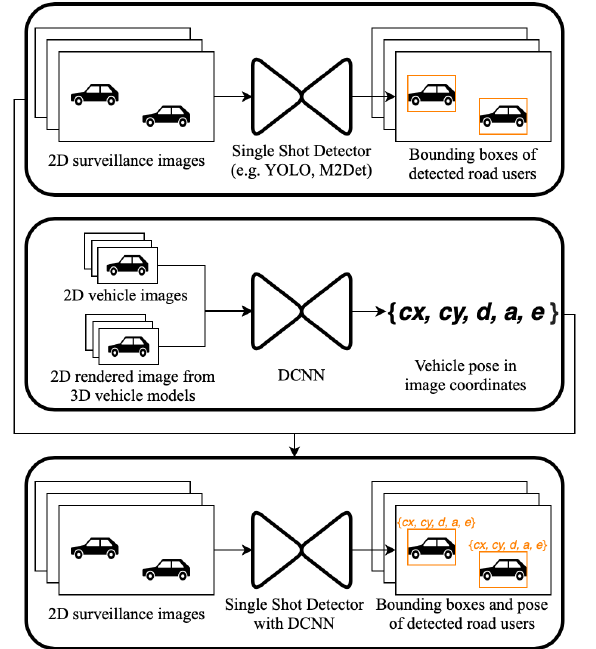
fed to two consecutive fully connected layers. The car tanh of the